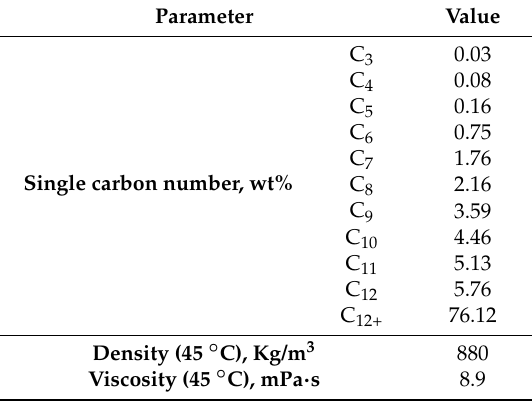
Table 1. Measured properties of oil samples.